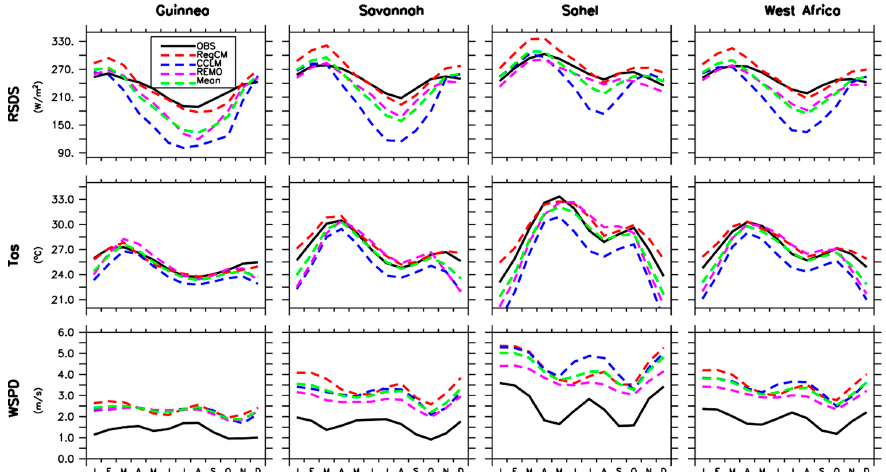
Energies 2022 , 15 , 9602